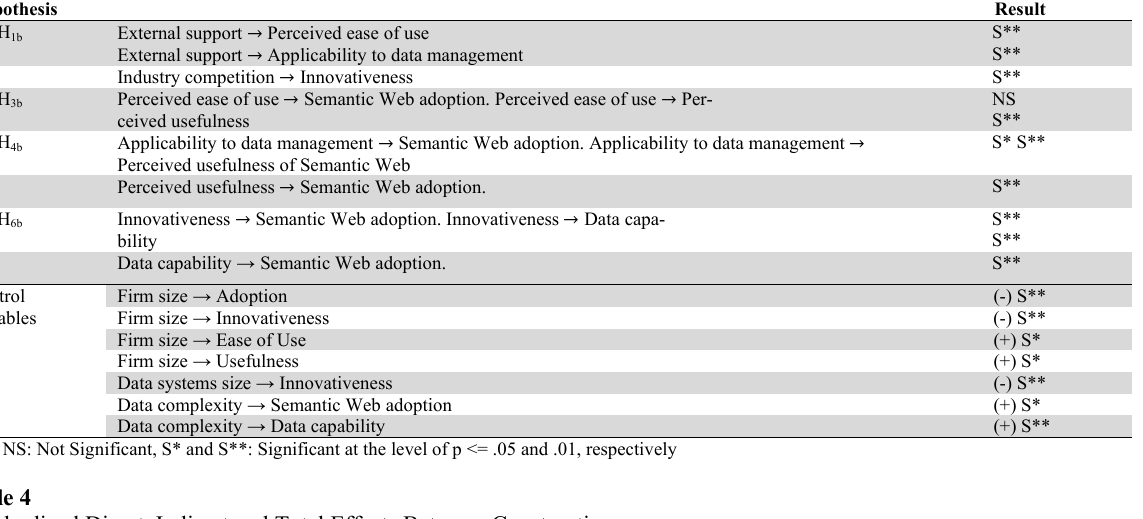
Summary of Hypotheses Testing Results